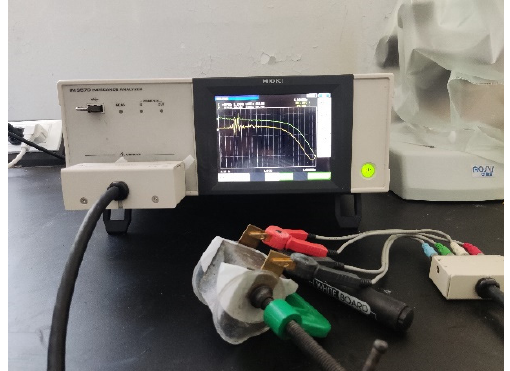
Figure 5. AC impedance